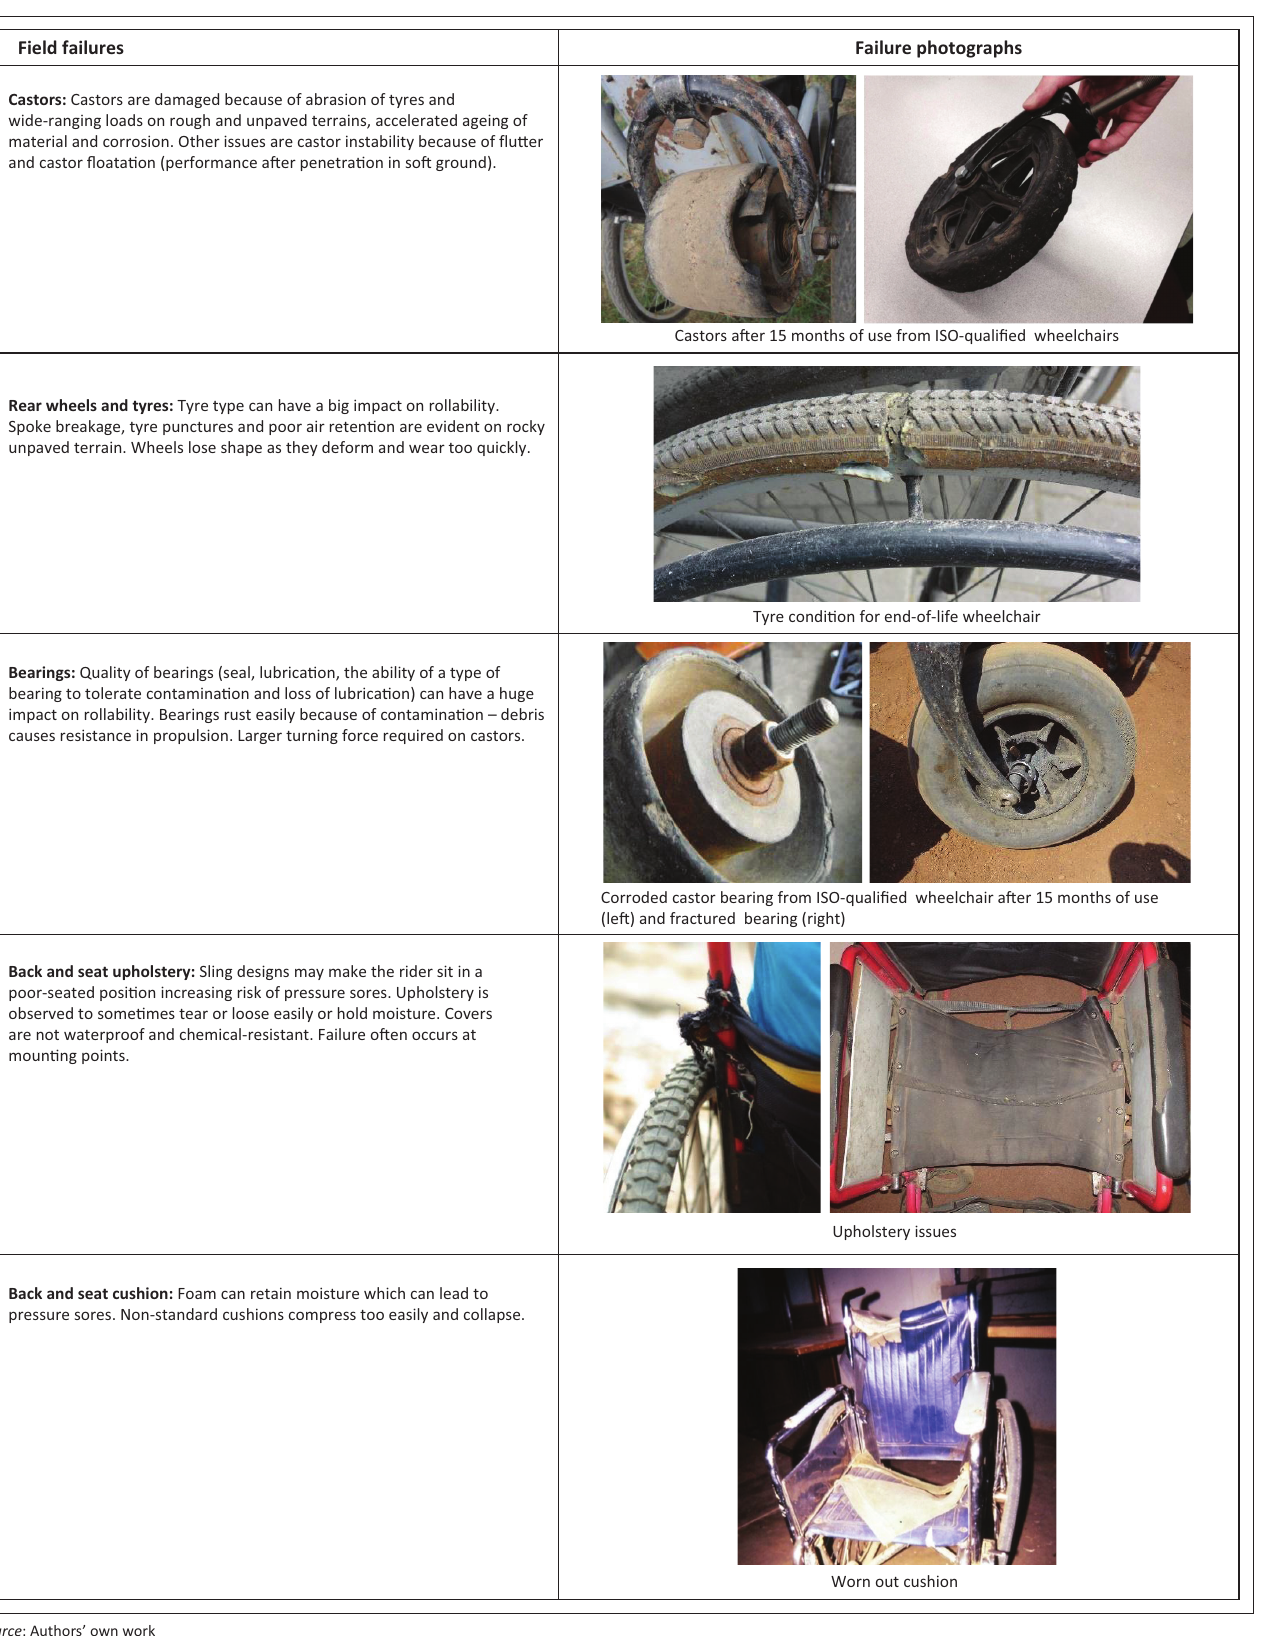
Castors: Castors are damaged because of abrasion of tyres and wide-ranging loads on rough and unpaved terrains, accelerated ageing of material and corrosion. Other issues are castor instability because of flu(cid:4)er and castor floata(cid:2)on (performance a(cid:127)er penetra(cid:2)on in so(cid:127) ground).